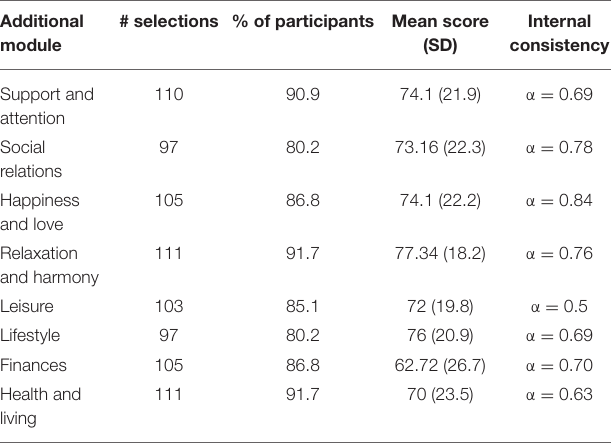
TABLE 5 | Mean total scores for the QoL-ME and MANSA at t0 and tfinal. t0 ( n =